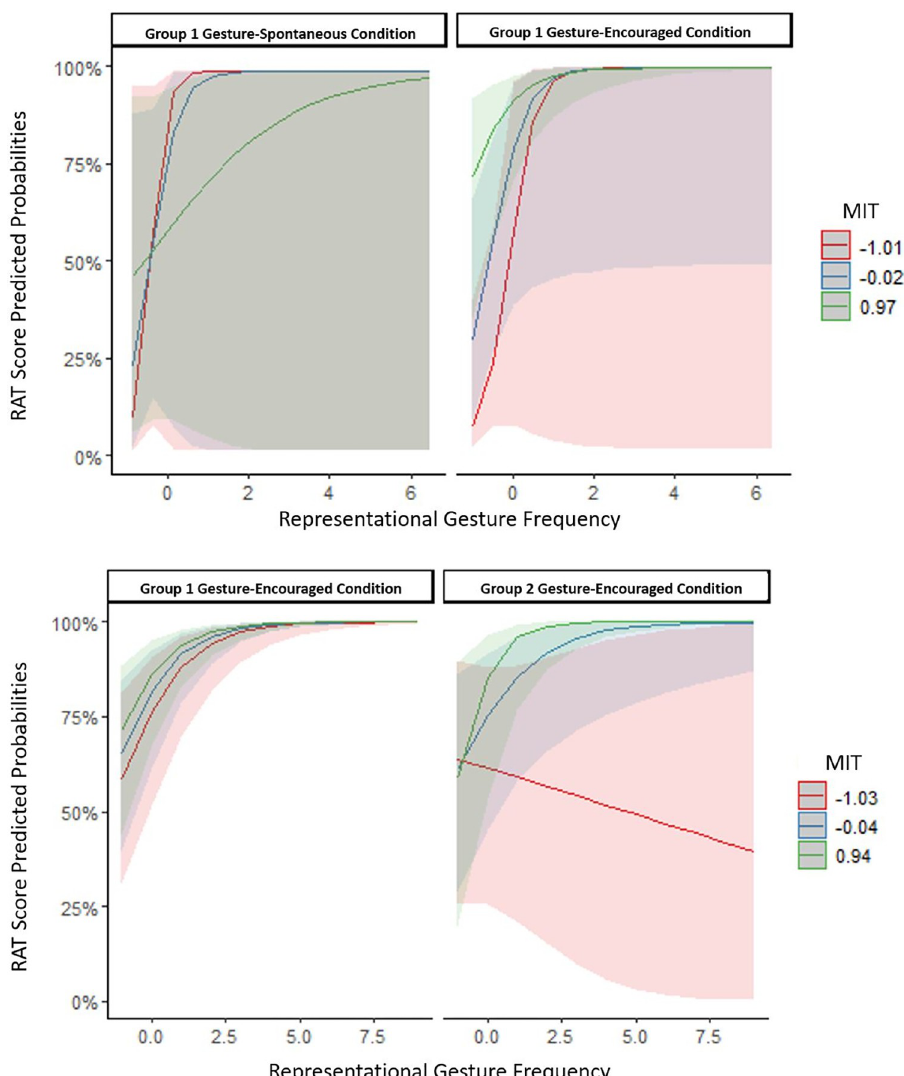
Fig 3. The relationship between predicted probabilities of RAT scores and scaled representational gesture frequency as a factor of scaled MIT scores (mean, below and above the mean) for the gesture-spontaneous and the gesture-encouraged condition of Group 1 and the gesture-encouraged condition of Group 2. A: within-subject effects; B: between-subject effects.